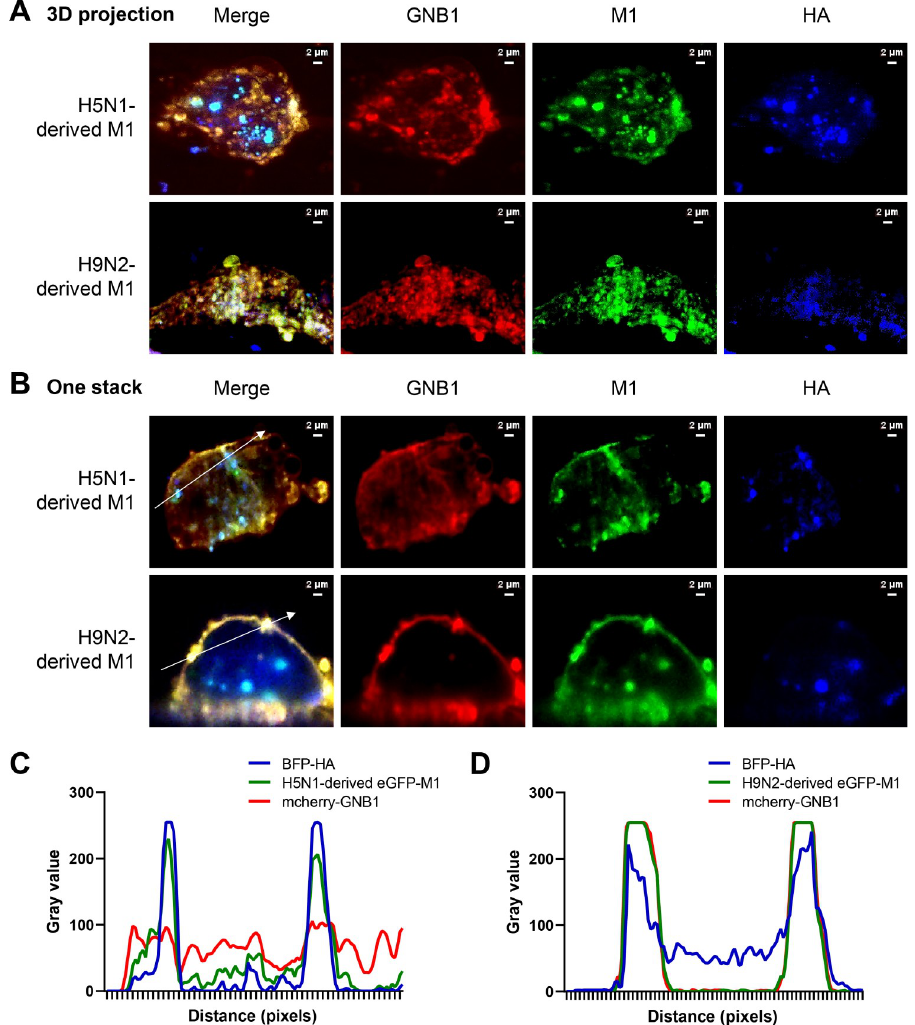
Fig 6. mCherry-GNB1 specifically co-localized with H9N2 virus-derived eGFP-M1 protein. (A–B) Visualization of the single-channel images showing the localization of BFP-HA (blue), eGFP-M1 (green), and mCherry-GNB1 (red) in A549 cells, measured after co-transfecting H9N2-derived eGFP-M1/BFP-HA/mCherry-GNB1 or H5N1-derived eGFP-M1/BFP-HA/mCherry-GNB1 in (A) 3D projection or (B) one stack (Z-start: 0.0 μ m, Z-end: 50.0 μ m, Z-step: 0.5000 μ m) using line profiles in image-analysis software platform Fiji. (C–D) The fluorescence intensity profile was plotted along the white arrow crossing the cell membrane in Fig 6B using ImageJ/Fiji software. The signal intensities (absolute gray values from 16-bit raw images) are plotted, where Y-axis shows the signal intensity, and X-axis shows the length of the line. The line profiles from three different channels are merged into one graph. Two different expression patterns are shown, highlighting the differences in the mCherry-GNB1 (red) and the similarities in the BFP-HA (blue) and eGFP-M1 (green) signal. Scale bars: 2 μ m.